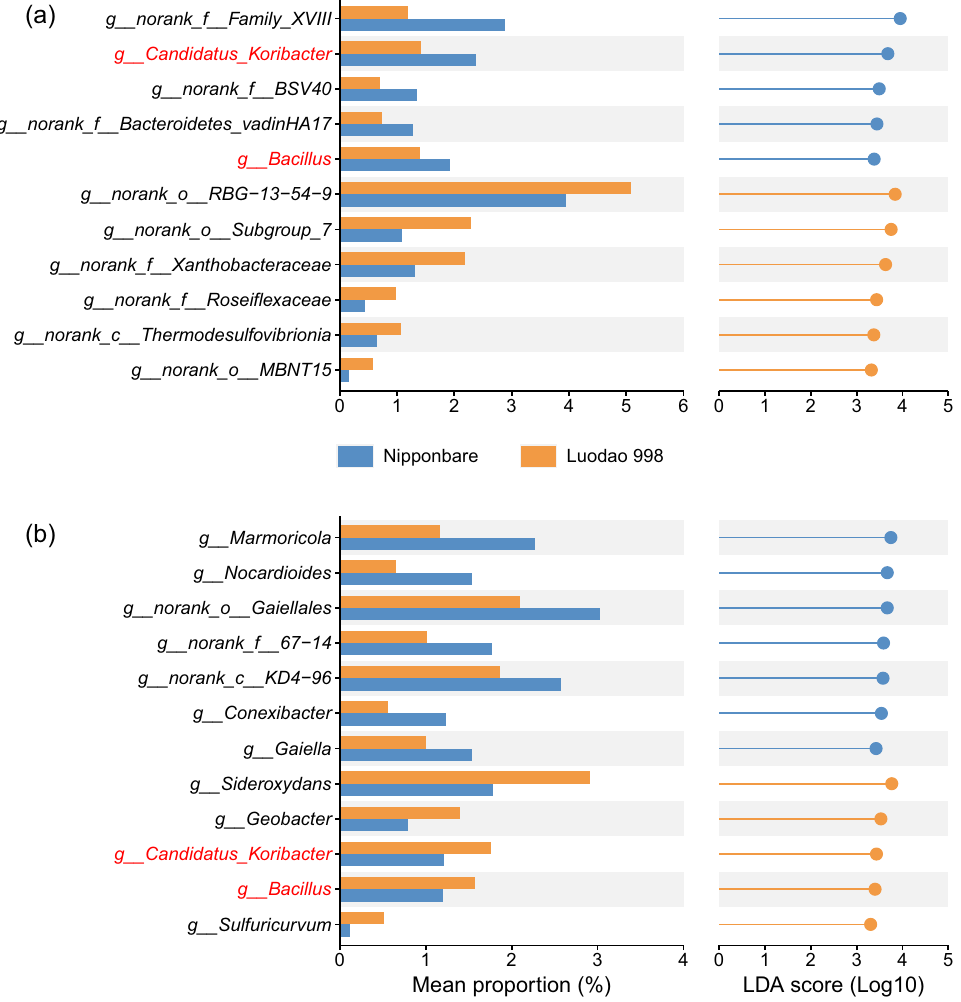
Fig. 4 Differentially abundant genera identified by LEfSe with logarithmic LDA > 3.3 in response to the two rice genotypes under a control and b drought conditions. The abscissa on the left represents the mean relative abundance of a certain genus in two distinct rice genotypes, and the ordinate represents the name of the genus. The name of the genus marked in red denotes that the genus is shared by the control and drought groups. The length of the line on the right reflects the LDA value, and the color of the nodes and lines indicates that the genus is significantly enriched in the corresponding rice